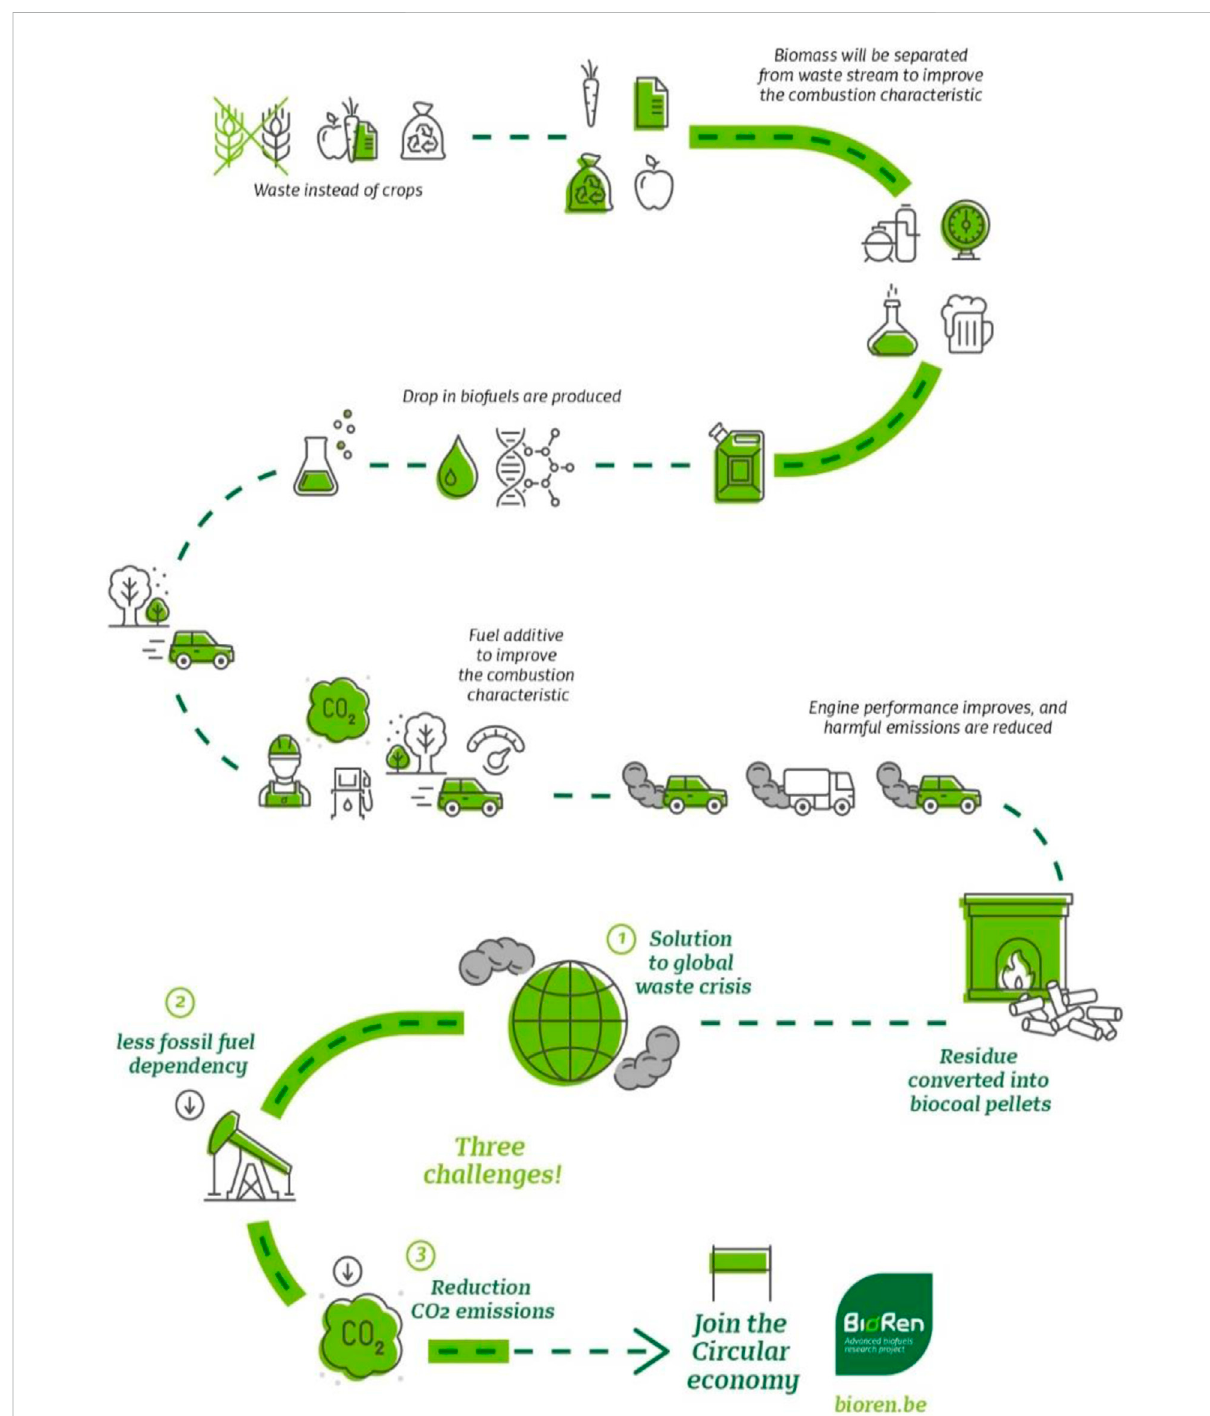
FIGURE 2 Objective of the BioRen process (BioRen,